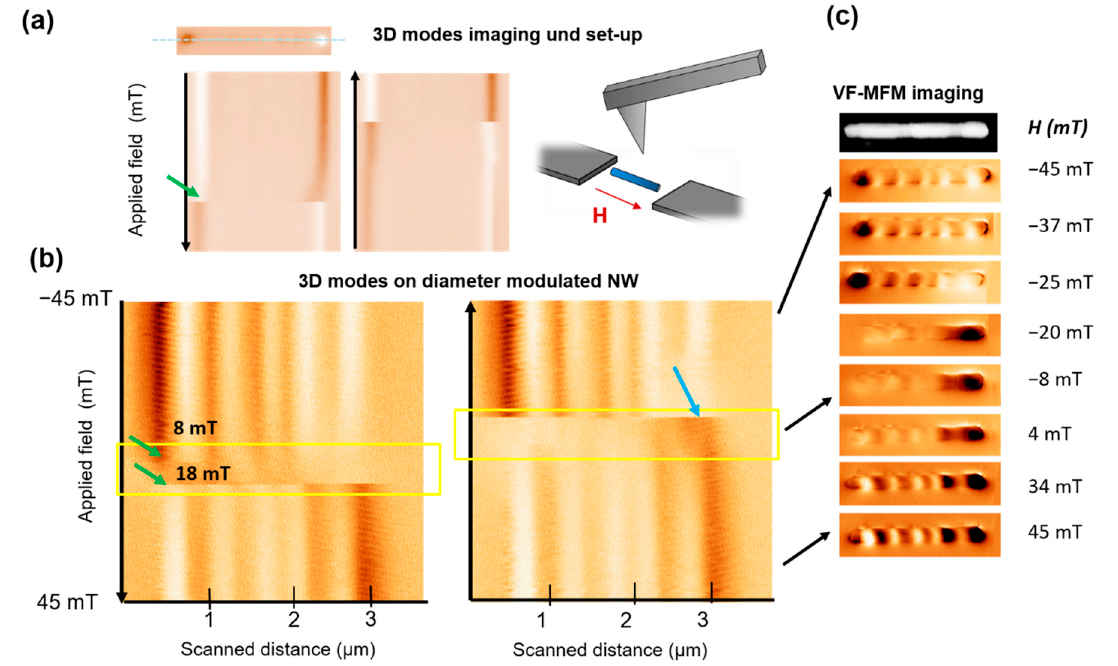
Figure 2. ( a ) Advanced MFM or 3D MFM operation modes on a single-domain magnetic nanowire. ( b ) 3D MFM image of a nanowire with modulated diameter. The area inside the yellow dashed square showing a dim signal is attributed to the presence of a skyrmion-tube. ( c ) MFM imaging sequence at changing field values, starting from positive applied field values.